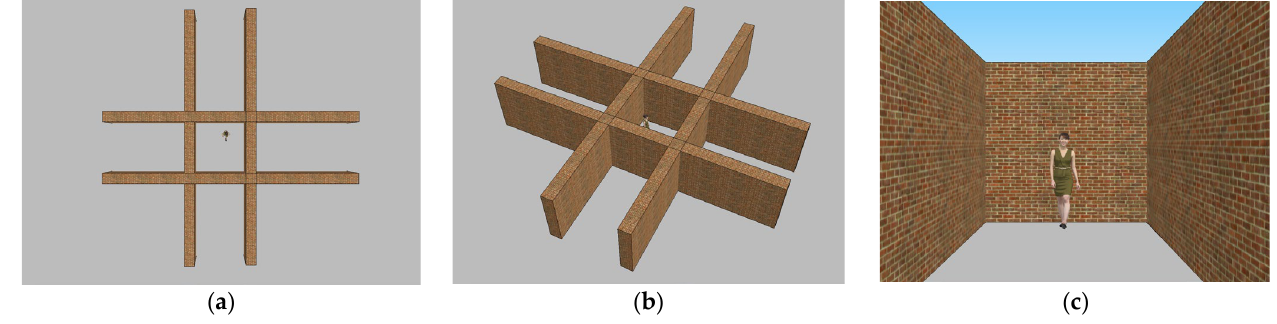
Figure 1. Three types of views utilized by participants for spatial decision-making when using the DT system: ( a ) plan, ( b ) birds’-eye, and ( c ) eye-level.